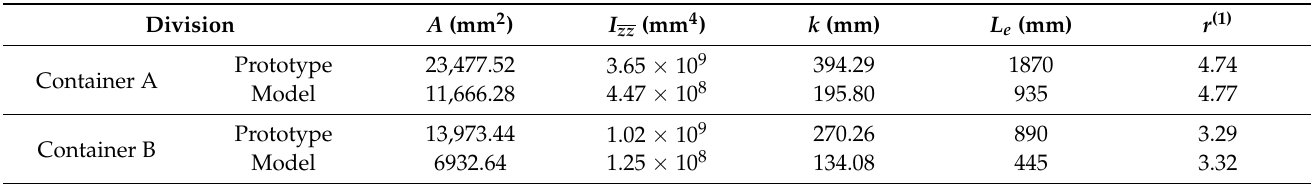
Table 3. Results of mechanical similarity analysis for buckling stress conditions between the prototype and model